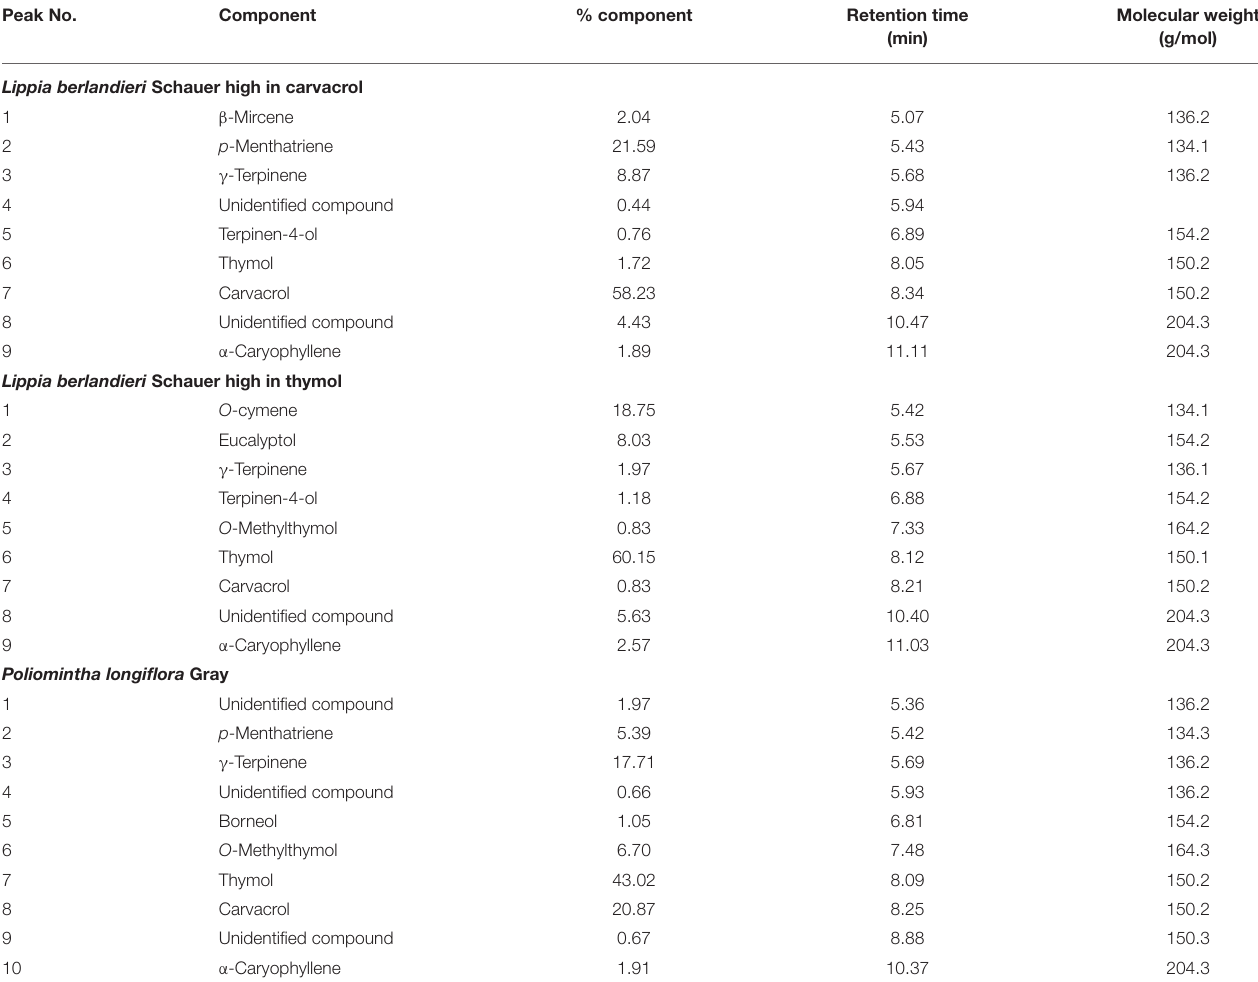
TABLE 1 | Chemical components of Lippia berlandieri Schauer and Poliomintha longiflora Gray essential oils. Peak